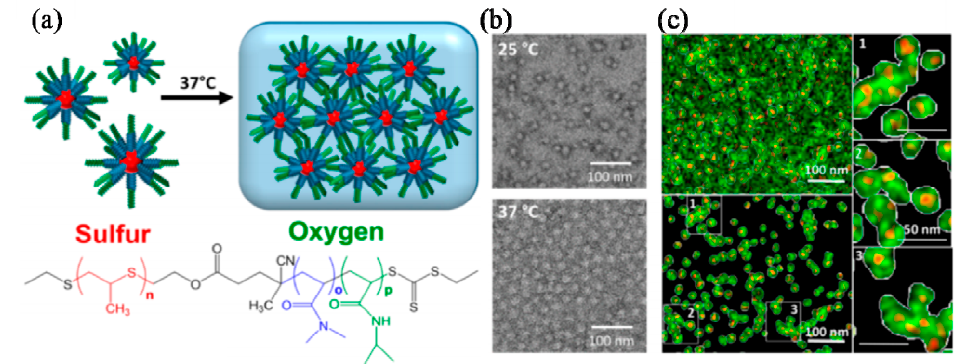
Figure 7. ( a ) Schematic representation of micelle gelation at 37 °C and polymer architecture coordinating with STEM-EDS element maps; ( b ) TEM images of PPS60- b -PDMA150- b -PNIPAAM150 micelles at 25 and 37 °C; ( c ) STEM-EDS element maps for sulfur (red) and oxygen (green) of PPS60- b -PDMA150- b -PNIPAAM150 core–shell compartments at 37 °C with image thresholding and background subtraction. Core-forming PPS produces the red signal for sulfur, while oxygen (appearing green) is present in the PDMA and PNIPAAM corona-forming blocks. Copyright 2014, American Chemical Society.